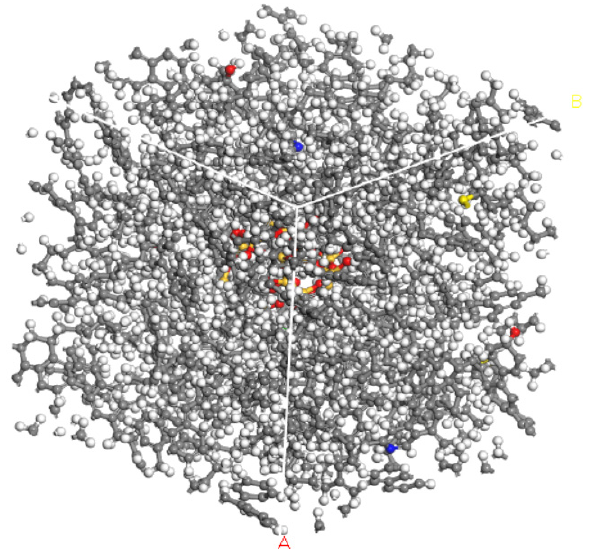
Figure 7. Nano-asphalt mixture model (C atoms in gray, H atoms in white, N atoms in blue, O atoms in red, and S atoms in yellow).